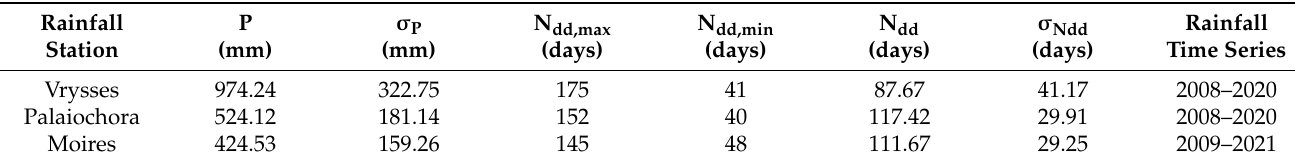
Table 2. Mean annual rainfall depth (P), maximum (N dd,max ), minimum (N dd,min ) and mean (N dd ) longest annual dry period for each rainfall station studied. The corresponding standard deviation values, σ P and σ Ndd, are also given.